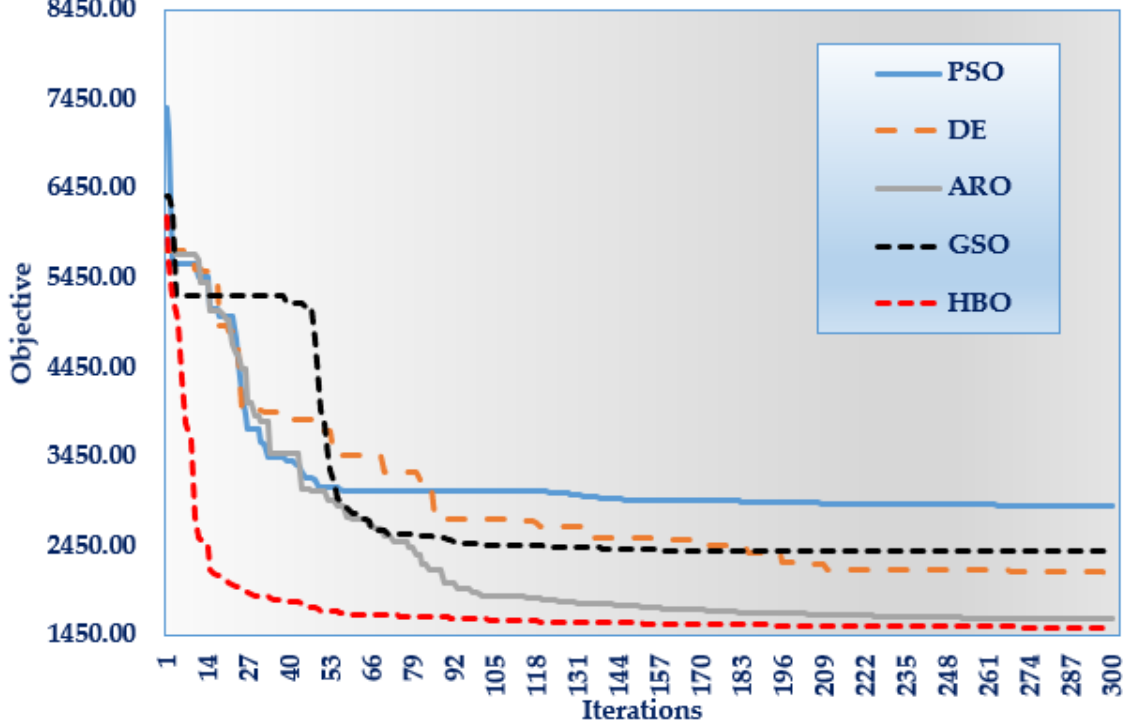
Figure 5. Convergence properties of the applied algorithms for IEEE 33-distribution feeder. Table 1. PV-STATCOM allocations for IEEE 33-distribution feeder.